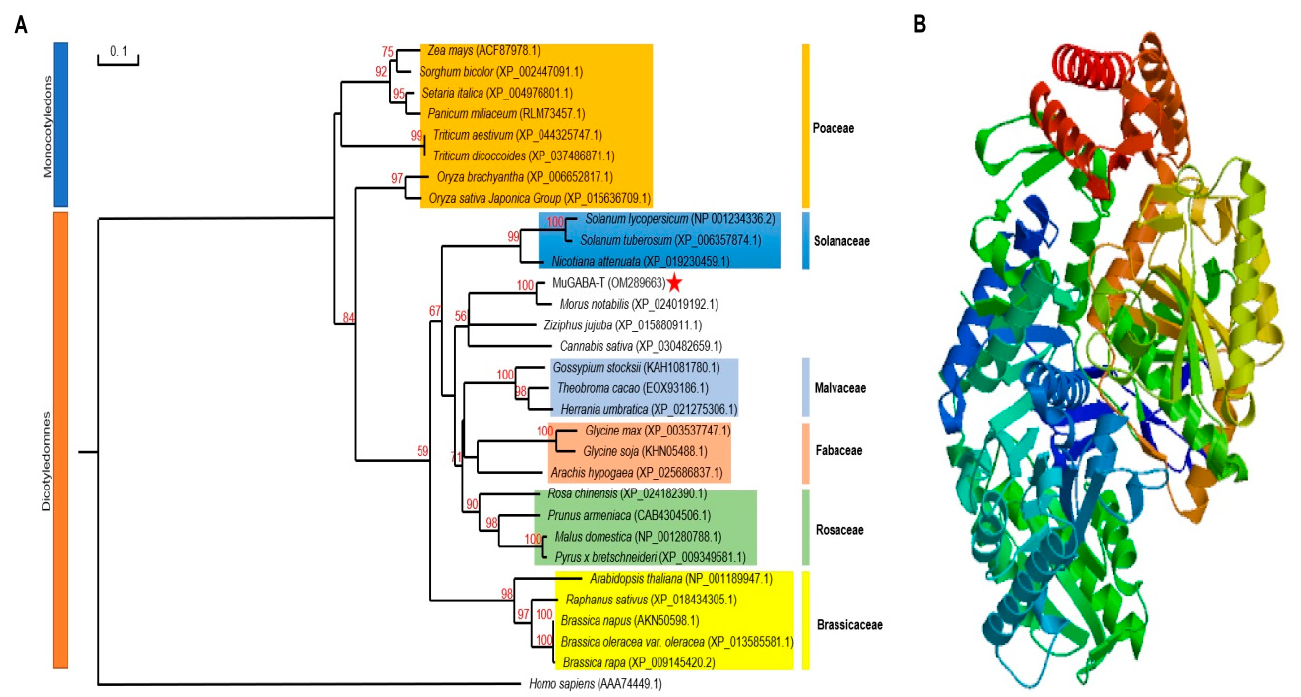
Figure 3. Phylogenetic analyses of GABA-T proteins from different plants and prediction of the three-dimensional structure of MuGABA-T protein. ( A ) The phylogenetic relationship of MuGABA-T and its homologous proteins. GenBank accession numbers of the proteins selected are shown in the brackets. Phylogenetic tree was generated using the neighbor-joining method with 1000 replicates. The bootstrap values are given on the nodes and the scale indicates genetic distance. ( B ) Three-dimensional structure of MuGABA-T proteins was built using SWISS-MODEL server by homology modeling.